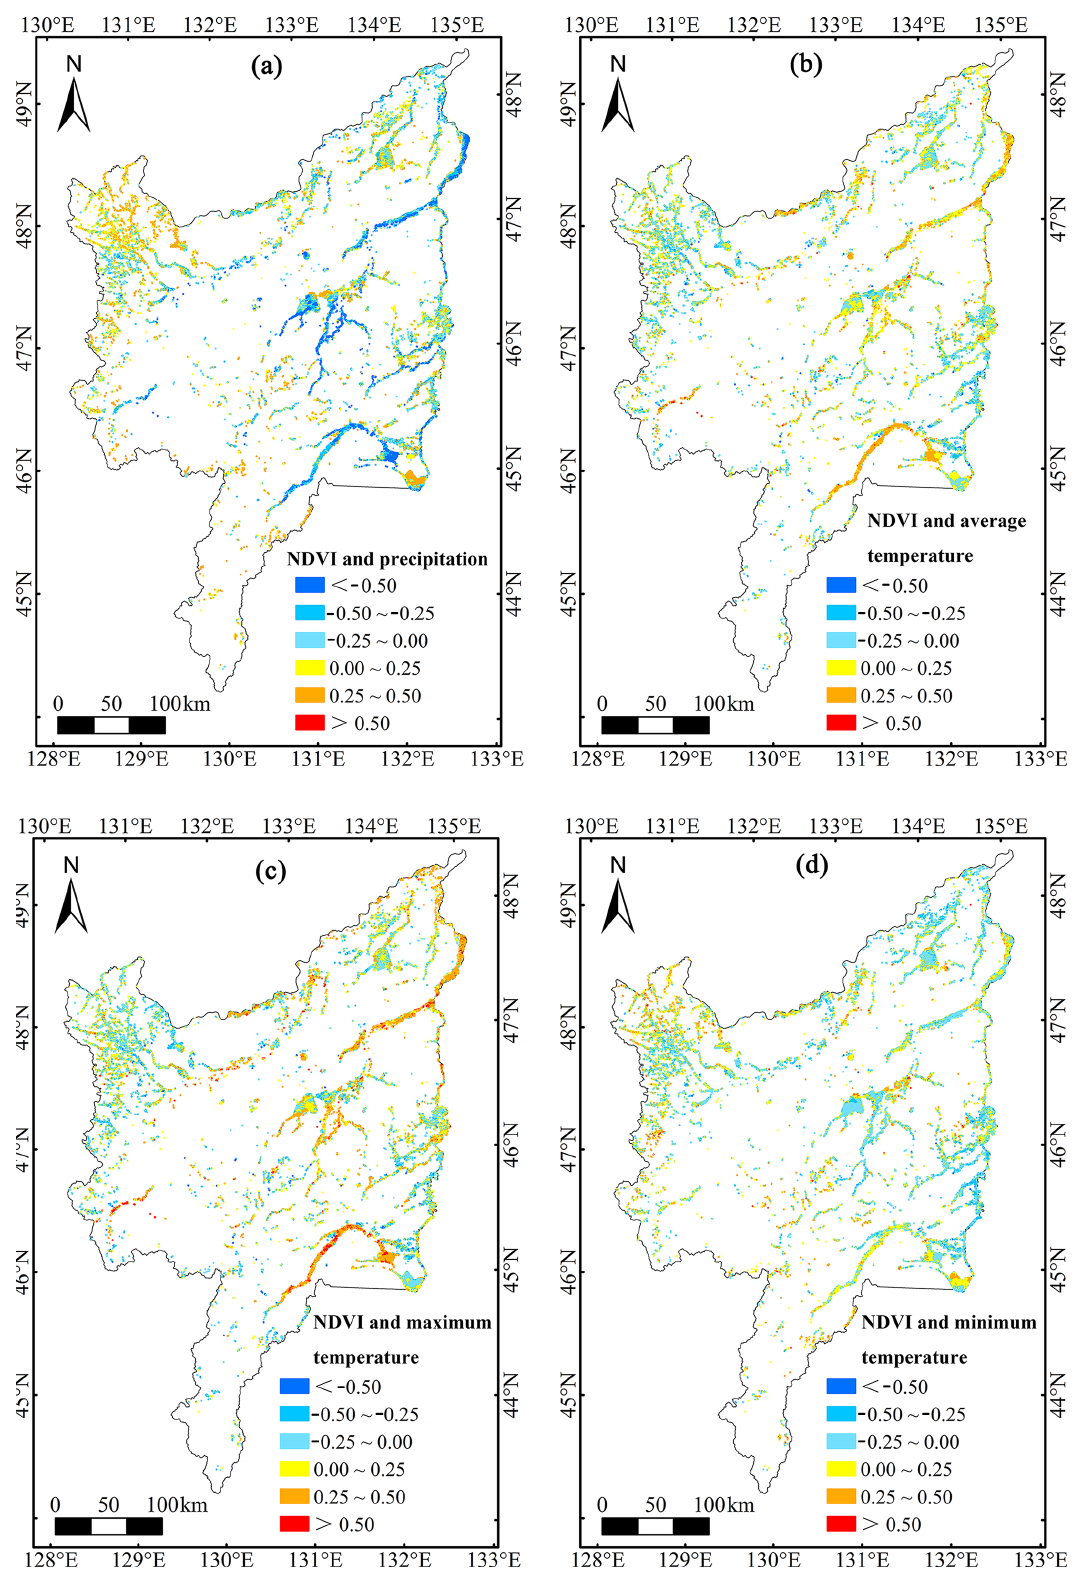
Figure 6. Spatial distribution of relationships between August NDVI of marsh vegetation and August ( a ) precipitation, ( b ) average temperature, ( c ) maximum temperature and ( d ) minimum temperature in the study region from 2000 to 2020.